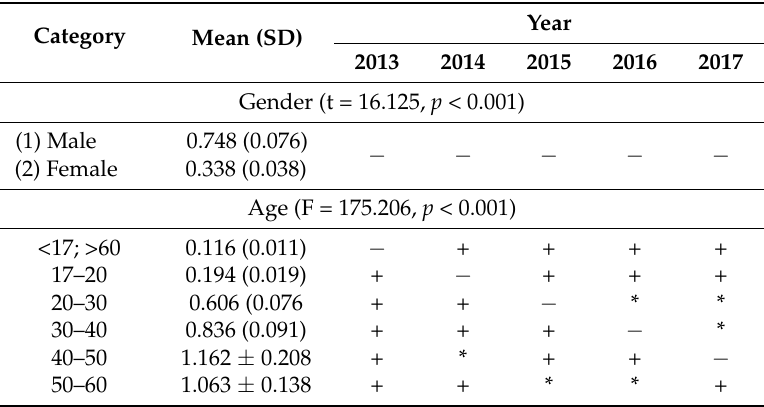
Table 6. Result of ANOVA analysis (frequency index of non-fatal).